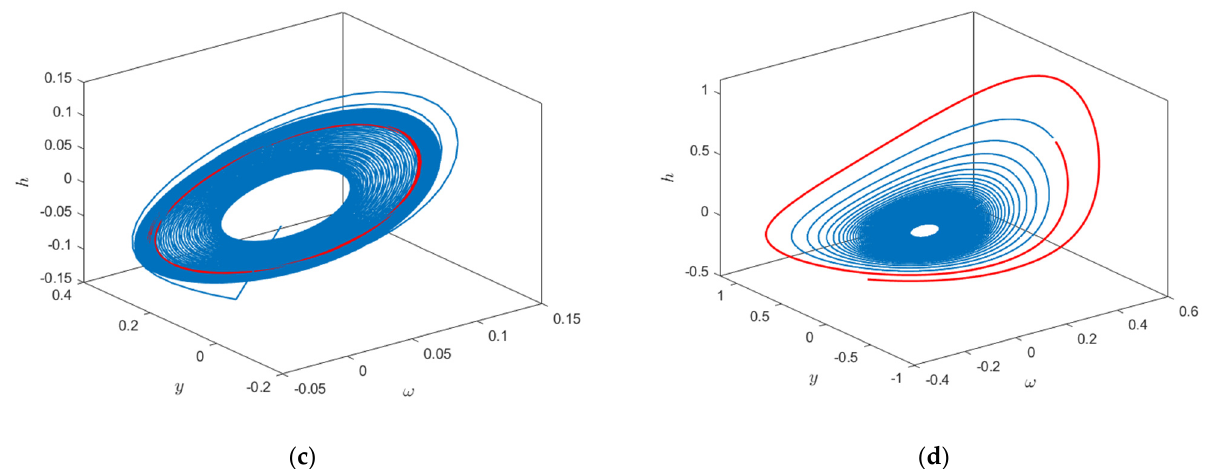
( d ) Figure 6. Dynamic responses of state variables x, y, ω for S 1 , S 2 , S 3 and S 4 . ( a ) S 1 ; ( b ) S 2 ; ( c ) S 3 ; ( d ) S 4 .